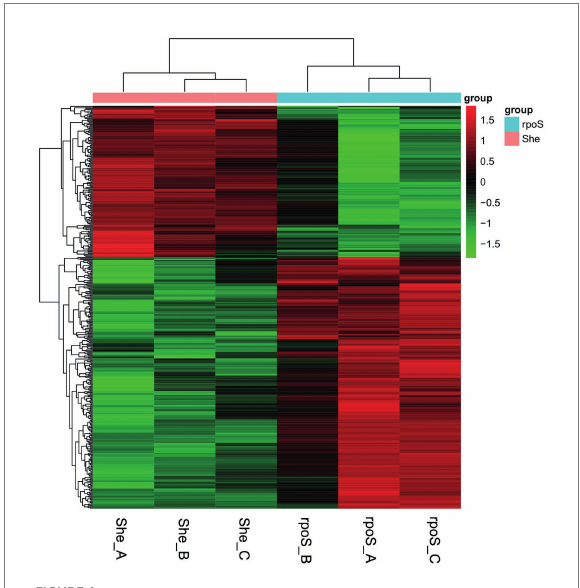
FIGURE 4 Heatmap of different expressed genes in Shewanella baltica and rpoS mutant. Each row represents the expression pattern of a single gene and each column corresponds to a single sample. “She” indicates S. baltica wild type, “ rpoS ” indicates the rpoS mutant.